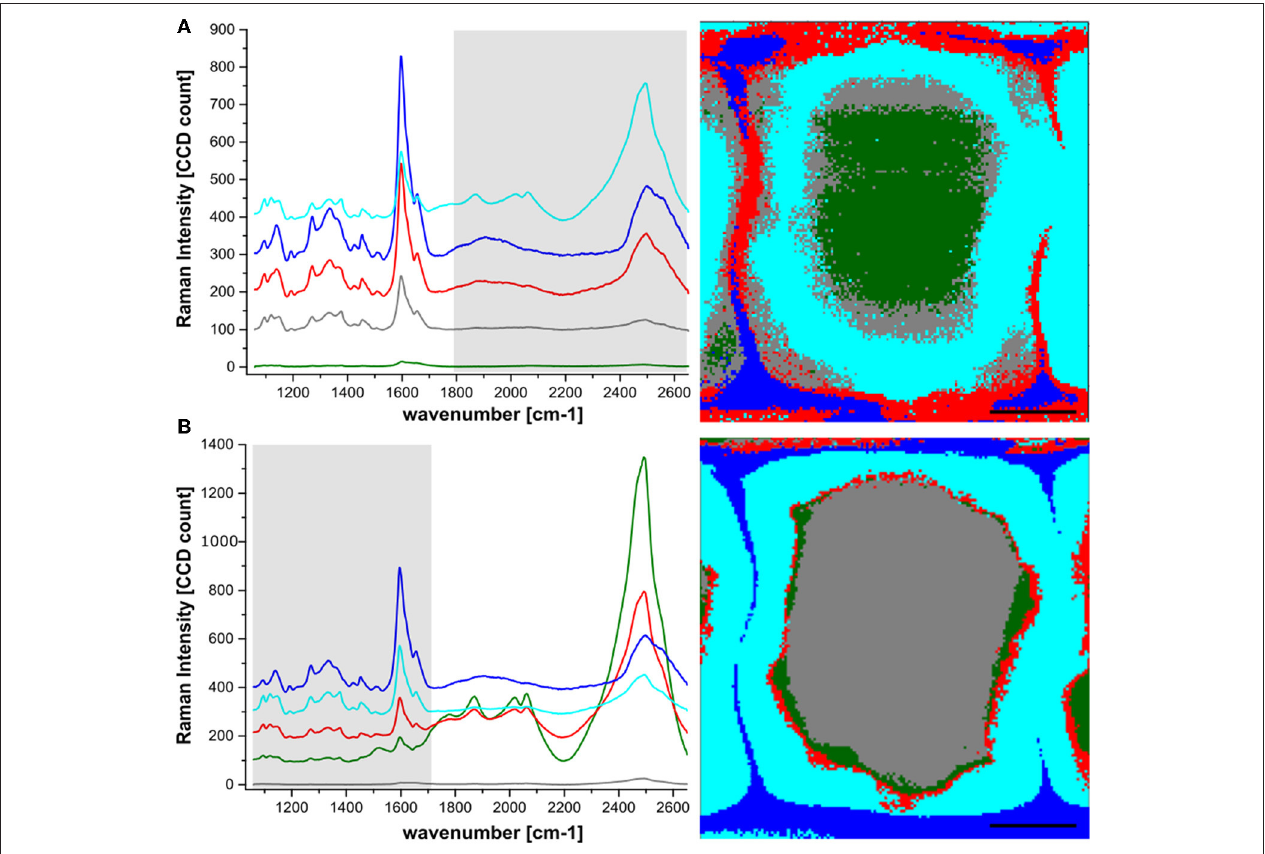
( Figure 5B ) was conducted for simultaneous recognition